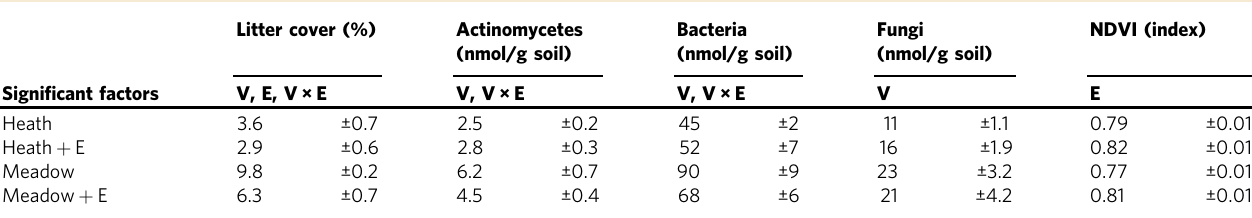
Shownareeffectsofvegetationtype(V)andearthwormtreatment(E)atacommunitylevelonlitter,microorganismsandthenormalizeddifferencevegetationindex(NDVI).Littercoverageisexpressed asaproportionofthemesocosmsoilsurface.Abundancesofactinomycetes,bacteria,andfungiaremeasuredusingphospholipidfattyacidanalysis(PLFA),whilethephotosynthesisactivity(greenness) of the plant community was measured using the NDVI, which is based on the plants ’ ability to re fl ect near-infrared light and adsorb red light. Values are mean±standard error. Statistically signi fi cant factors ( P <0.05) in the linear mixed effect model are given in the row above the